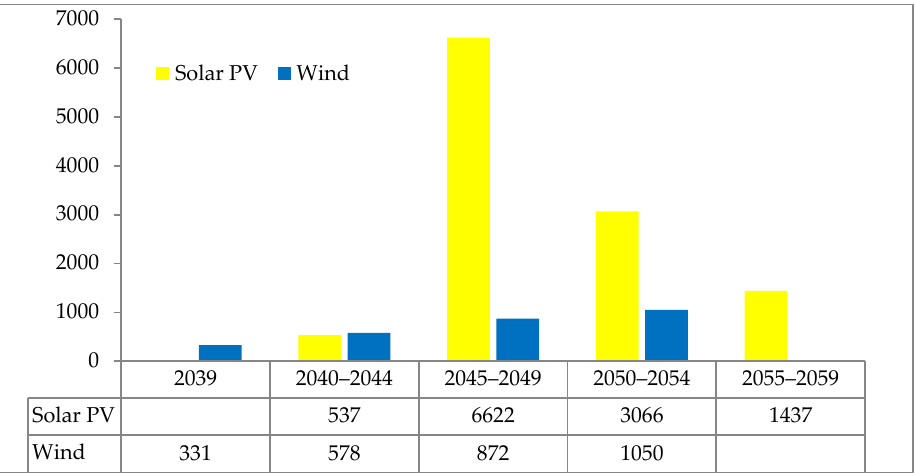
Figure 4. Employment (numbers of jobs) involved in decommissioning of solar and wind power plants in Ukraine.